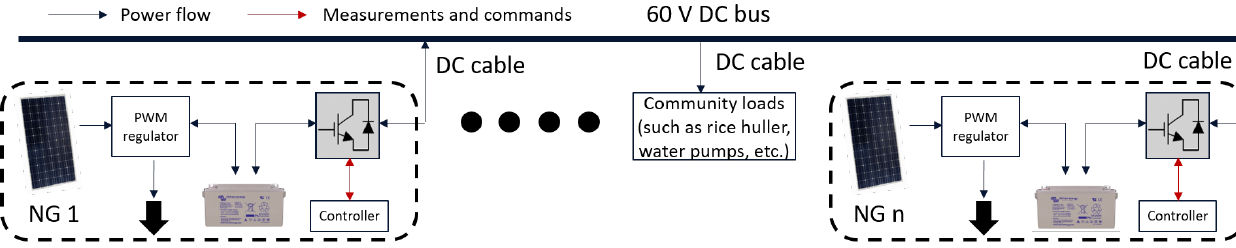
Figure 6. Configuration of the proposed